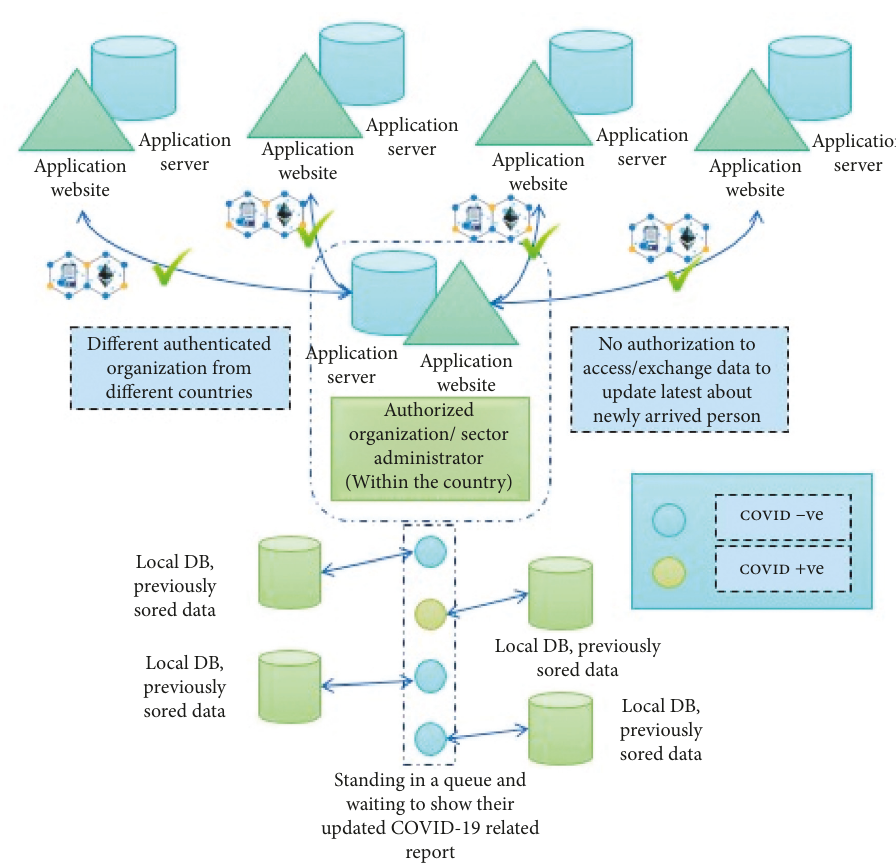
Figure 3: Request for outside-country service